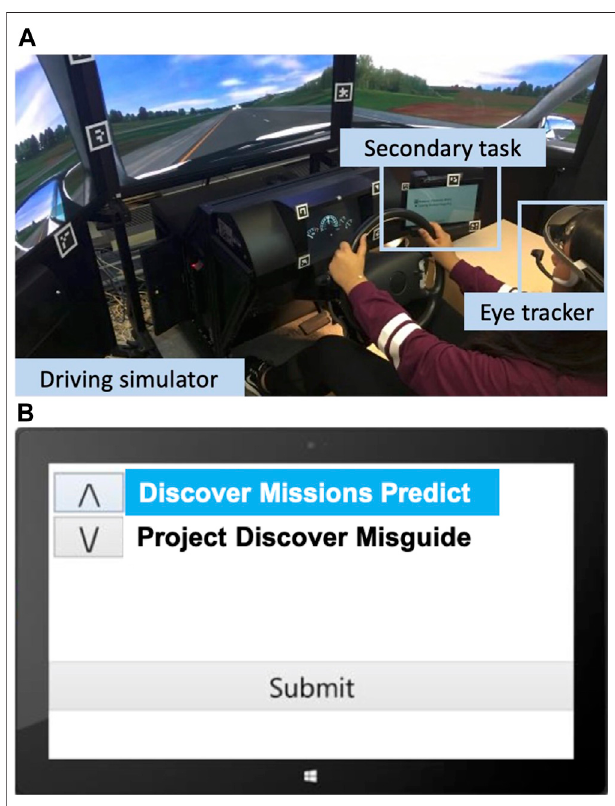
FIGURE 1 | (A) NADS MiniSim driving simulator; (B) Screenshot of the secondary task.